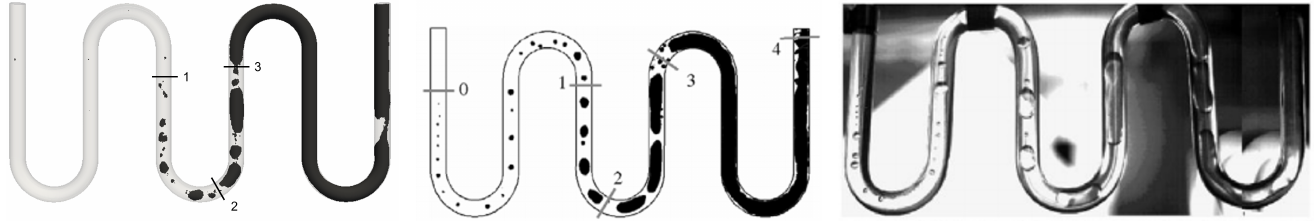
Figure 7. Comparison of the obtained regime transition to Yang’s results [1]. ( Left ): NEP- TUNE_CFD simulation—instantaneous visualization of isocontour α v = 0.5. ( Center ): Fluent simulations [1]. ( Right ): Experience [1]. Flow regimes 0–1: bubbly, 1–2: churn, 2–3: slug, 3–4: